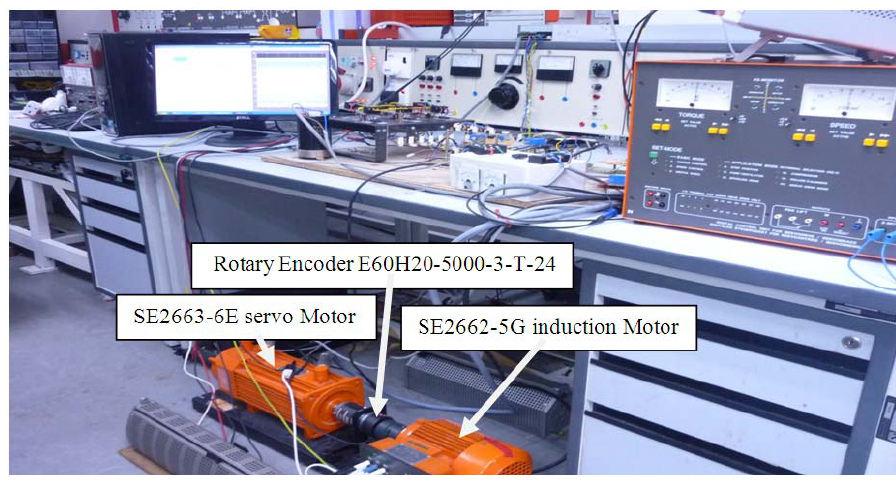
Figure 14. Induction motor setup.